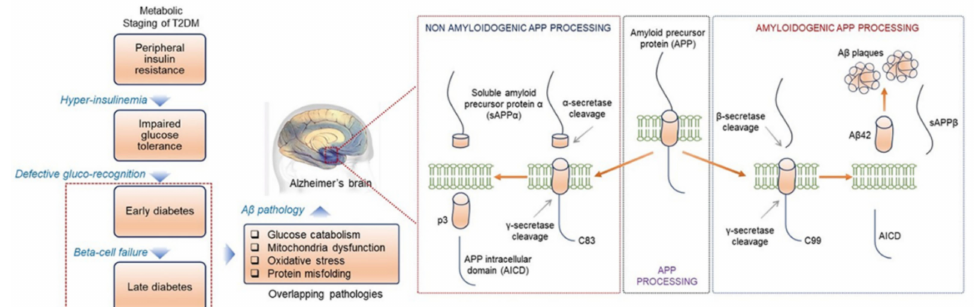
Figure 5. Proteolytic cleavage of APP. In the non-amyloidogenic pathway, the extracellular domain cleavages by α -secretase and releases the soluble peptide sAPP α . In contrast, the amyloidogenic pathway releases A β 42, a significant component of A β